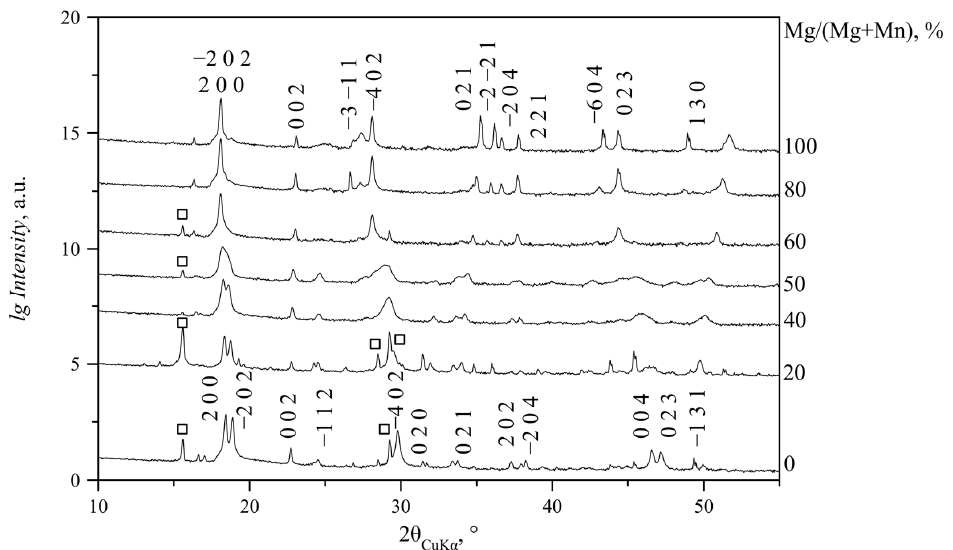
series). (cid:3) —peaks of MnC 2 O 4 · 2H 2 O phase (Sp. gr. P 2 1 2 1 2 1 ). The remaining peaks belong to (Mn, Figure 3. PXRD patterns of precipitates obtained at Mg/(Mg + Mn) = 0–100% in solution (NC se- ries). □ —peaks of MnC 2 O 4 ∙ 2H 2 O phase (Sp. gr. P 2 1 2 1 2 1 ). The remaining peaks belong to